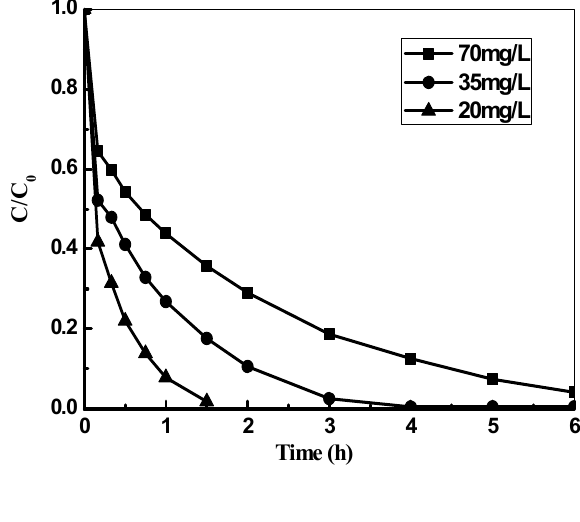
on the immobilized efficiency onto 4